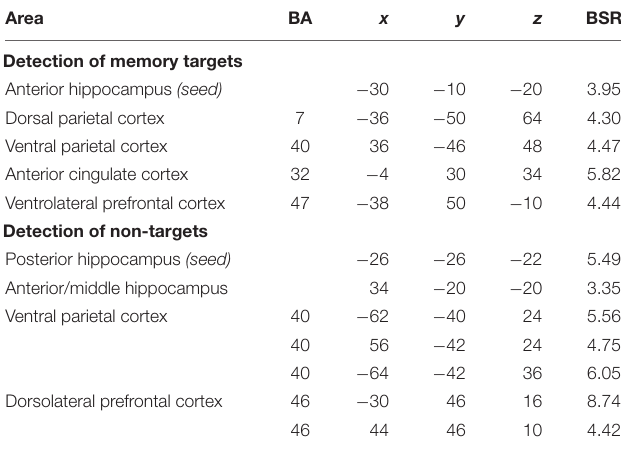
TABLE 4 | Hippocampal functional